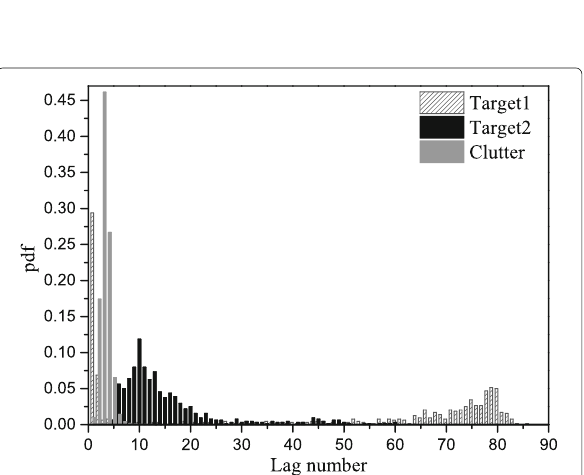
Fig. 4 Statistical results of the decreasing rate of the correlation time for the sea clutter and